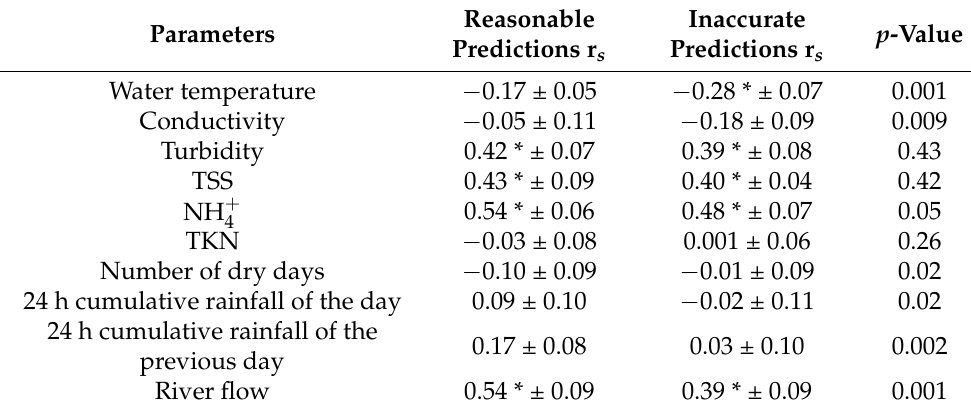
Table 1. Correlation coefficients (average r s ± SD) for the relationship between the values of E. coli predicted by the RF model (reasonable and inaccurate) and the environmental variables. Significant coefficients are indicated with a * (coefficient significance test p < 0.05). Significant differences between the correlation coefficients of the two datasets are indicated as t -test p -values < 0.01. MAPE values were used to identify reasonable (less than 50%) and inaccurate (over 50%) estimations of E. coli concentrations obtained with the RF model during the ten testing